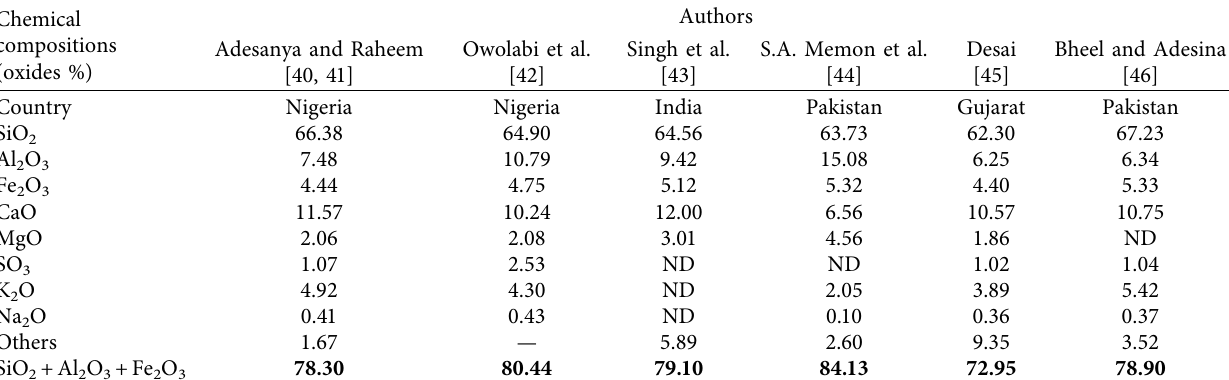
Table 3: Chemical composition of corncob leaves’ ashes